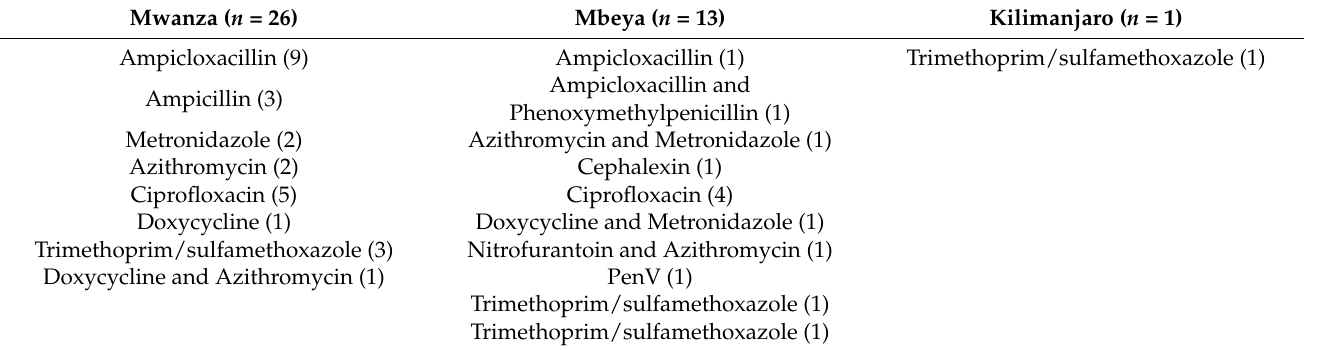
Table 3. List of alternative drugs sold and number of sellers who sold